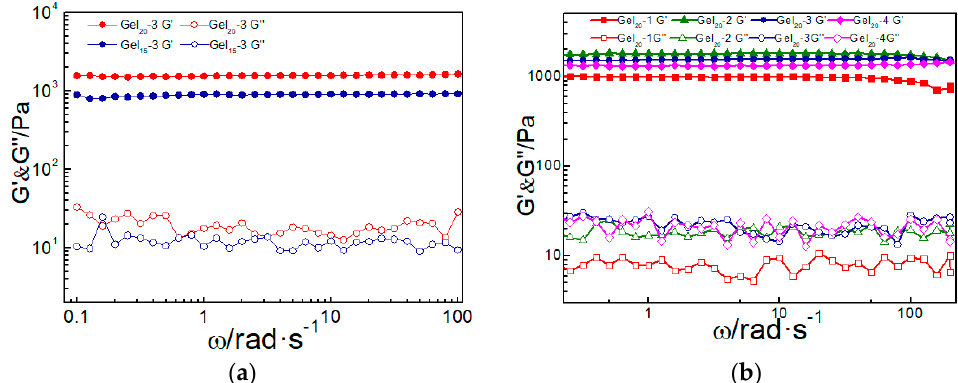
Figure 2. ( a ) Frequency sweep measurements of hydrogels Gel 15 -3 and Gel 20 -3; ( b ) Storage moduli (G ′ ) and loss moduli (G ″ ) of hydrogels Gel 20 -1, Gel 20 -2, Gel 20 -3, and Gel 20 -4 as a function of angular frequency.